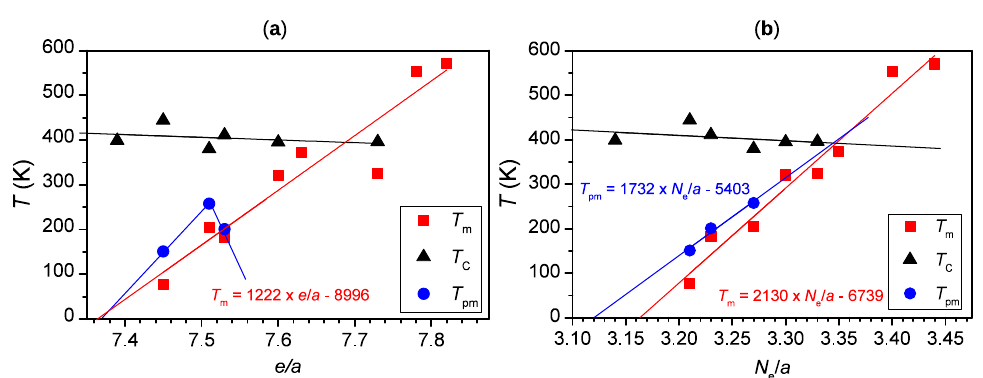
Figure 5. Premartensitic ( T pm ), martensitic ( T m ) and Curie ( T C ) transition temperatures as ( a ) a function of number of valence electrons per atom ( e/a ) and ( b ) a function of number of non-bonding electrons per atom ( N e / a ). Linear fit of T m is well correlated to both e/a and N e / a ; T C does not exhibit a good linear fit.